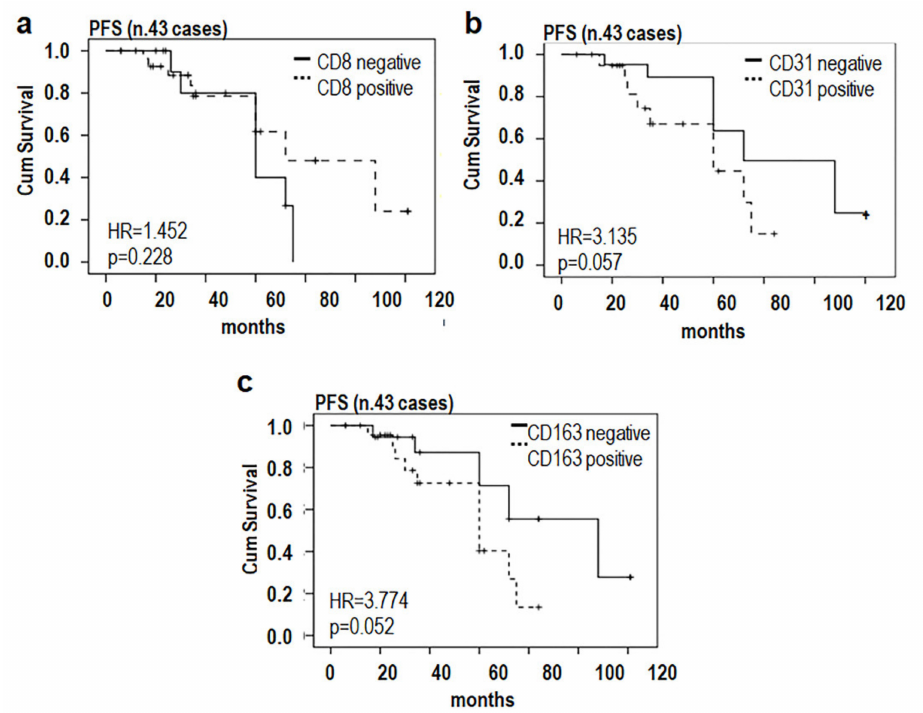
Figure 4. Prognostic implication of macrophages and microvessel density in MLPS. Kaplan–Meier analysis (Log-rank, Mantel–Cox test) used to evaluate the PFS, based on tumor-infiltrating CD8+ ( a ), CD31+ microvessels ( b ) and CD163+ cells ( c ) in 43 MLPS cases. Patients who were lost to clinical follow-up were censored from PFS at time lost to clinical follow-up (nine low and three high grade MLPS cases censored). Time was defined as the interval between the date of diagnosis and the date of disease recurrence or that of the last follow-up visit. HR, hazard